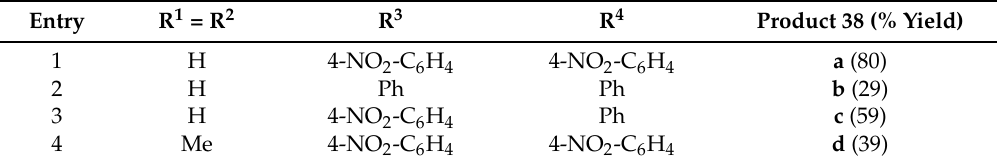
Table 4. Cycloaddition of azomethine ylide 37 to aromatic aldehydes 2a and 2i (Scheme